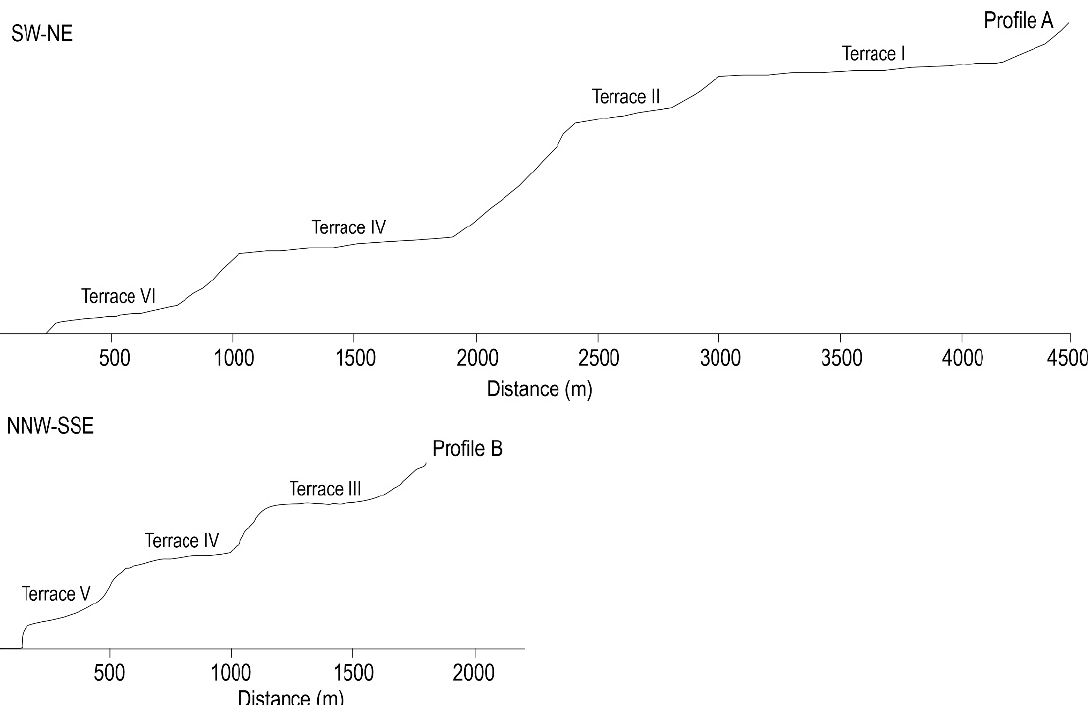
Figure 12. Topographic profiles A and B constructed at Capes Agia Pelagia and Mounta, respectively. For locations of the profiles, see map in Figure 4.